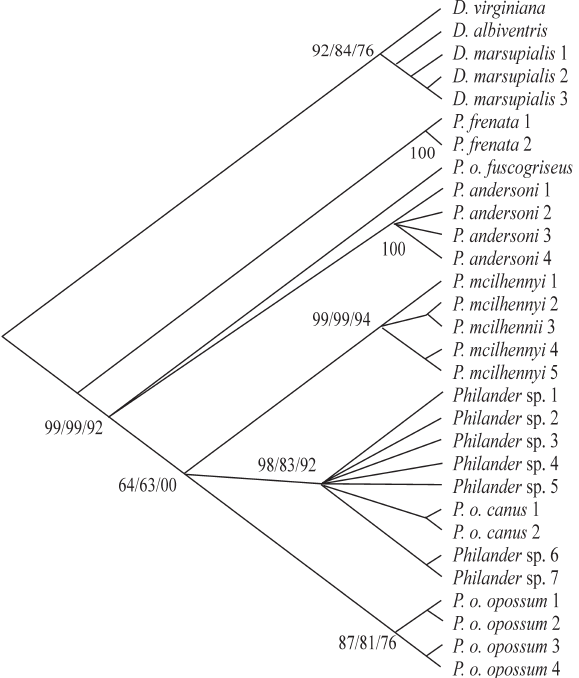
Figure 1 - Consensus tree of 433 base pairs of the mitochondrial Cyto- chrome B (CytB) gene with bootstrap values on the right corresponding to maximum likelihood (ML), Neighbor-Joining (NJ) and Maximum parsi- mony (MP) analyses,